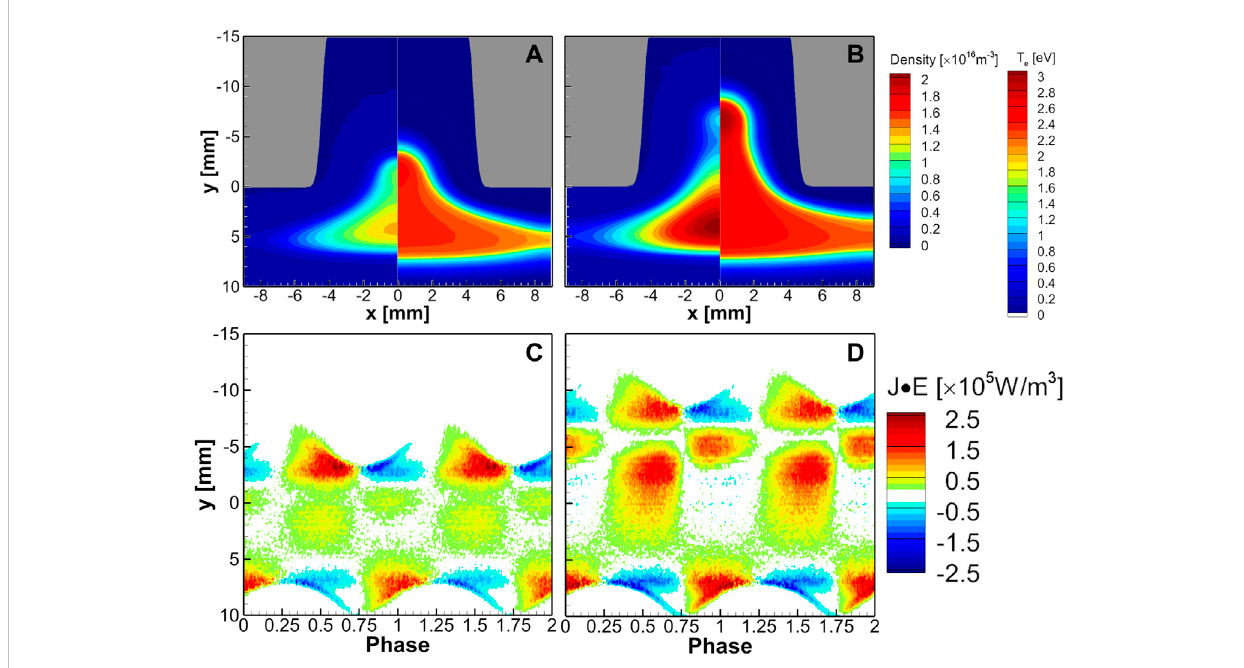
FIGURE 11 Shownaretime-averagedspatialpro fi lesofelectrondensity(leftside)andtemperature(rightside)undertheconditionsof d =8 mmand h =15 mm withaGaussianshapeslopewithagaspressureof0.6Torr.AnRFvoltageof200 Vatafrequencyof13.56 MHzwasappliedtotheupperelectrodewitha DC bias voltage of (A) − 30 V and (B) +30 V. The phase-resolved spatiotemporal pro fi les at x = 0 are plotted for the electron power absorption with a DC bias voltage of (C) − 30 V and (D) +30